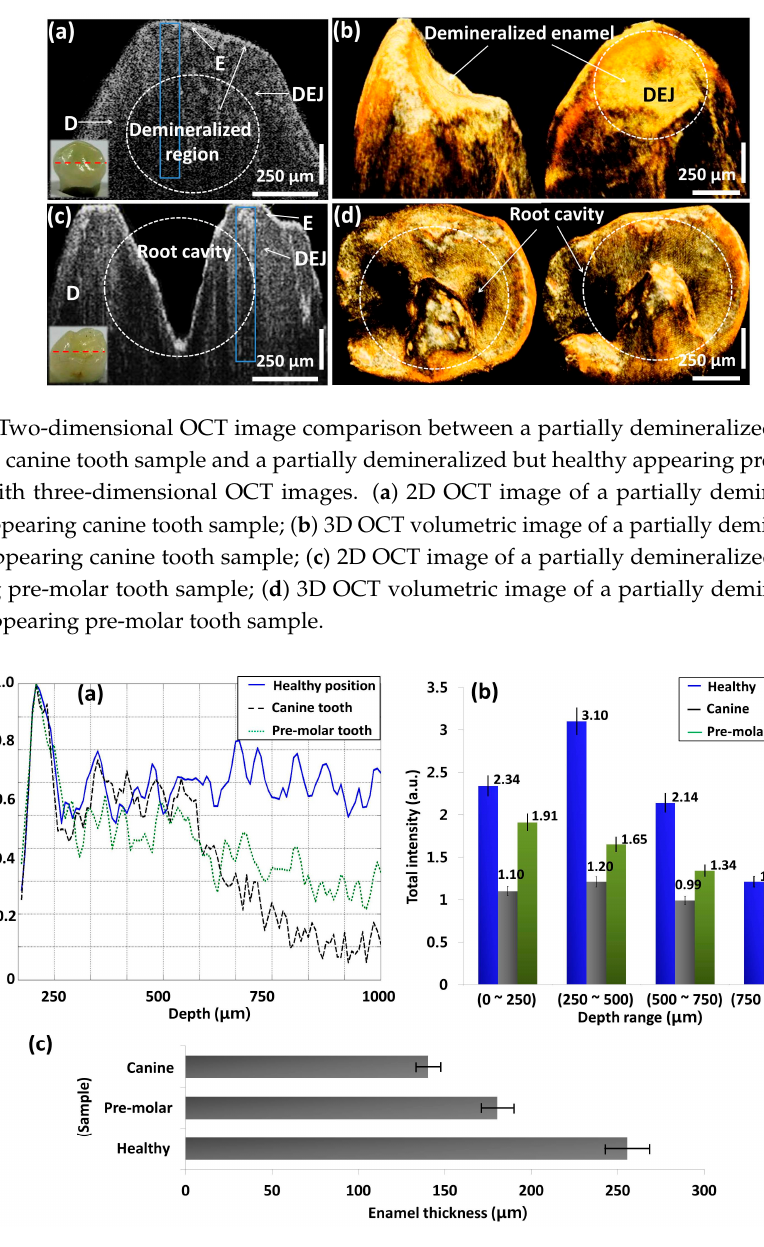
Figure 6. The quantitative evaluation for a healthy sample and partially demineralized but healthy appearing canine and pre-molar tooth samples. ( a ) A-scan depth profiles of healthy and partially demineralized but healthy appearing canine and pre-molar tooth samples; ( b ) the total intensity fluctuation of healthy, canine, and pre-molar tooth samples for the entire visible depth range of 1 mm with a gap of 250 μ m depth range; ( c ) the depth direction enamel thickness values of the healthy, partially demineralized but healthy appearing canine and pre-molar tooth samples.